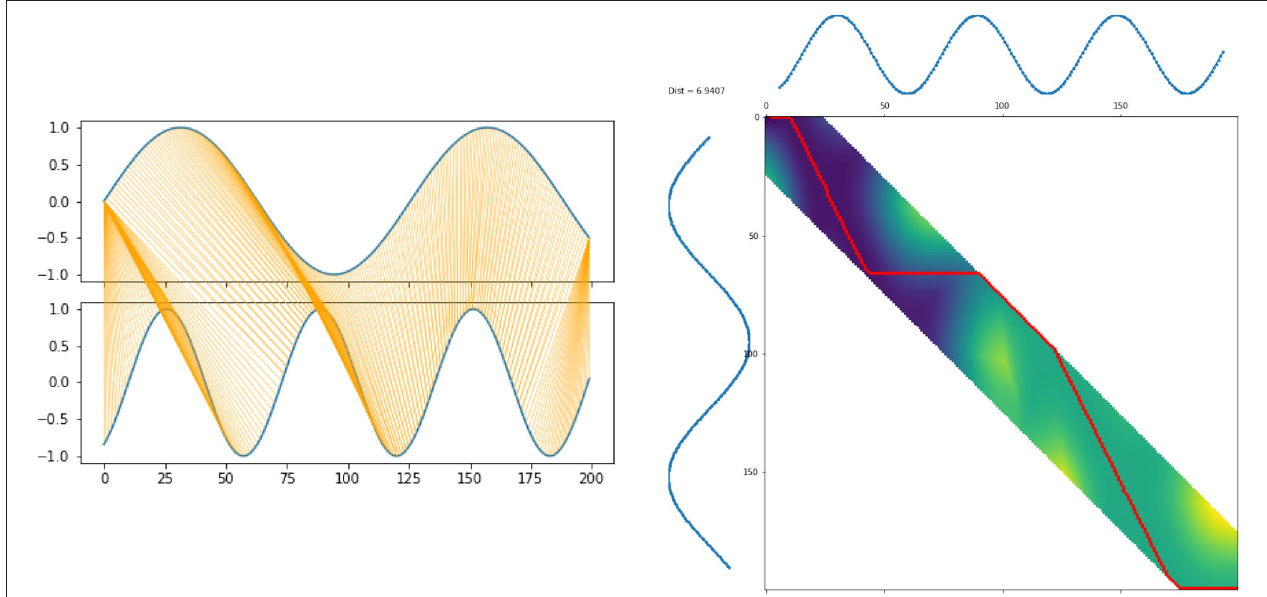
FIGURE 3 | DTW warping (left) and warpings paths (right)